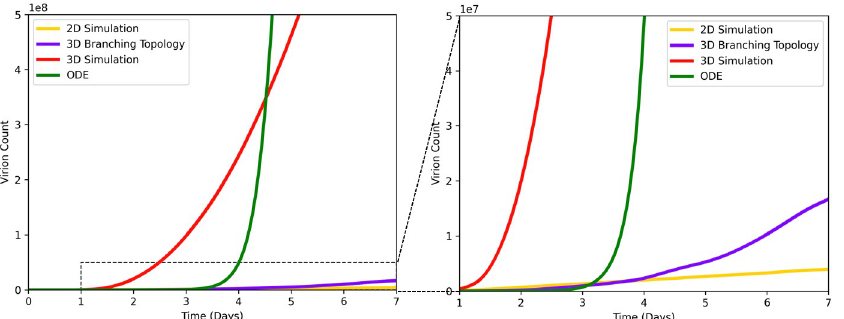
Fig 8. Viral spread from a single FOI given different model topologies. Virion count is plotted vs. time for four different SIMCoV configurations: 2D grid (yellow); 3D grid (red); 3D branching model (blue); ODE model (green). The right panel is zoomed in on the y-axis (showing up to 10 7 virions) to show the dotted region of the left panel (which shows up to 10 8 virions).